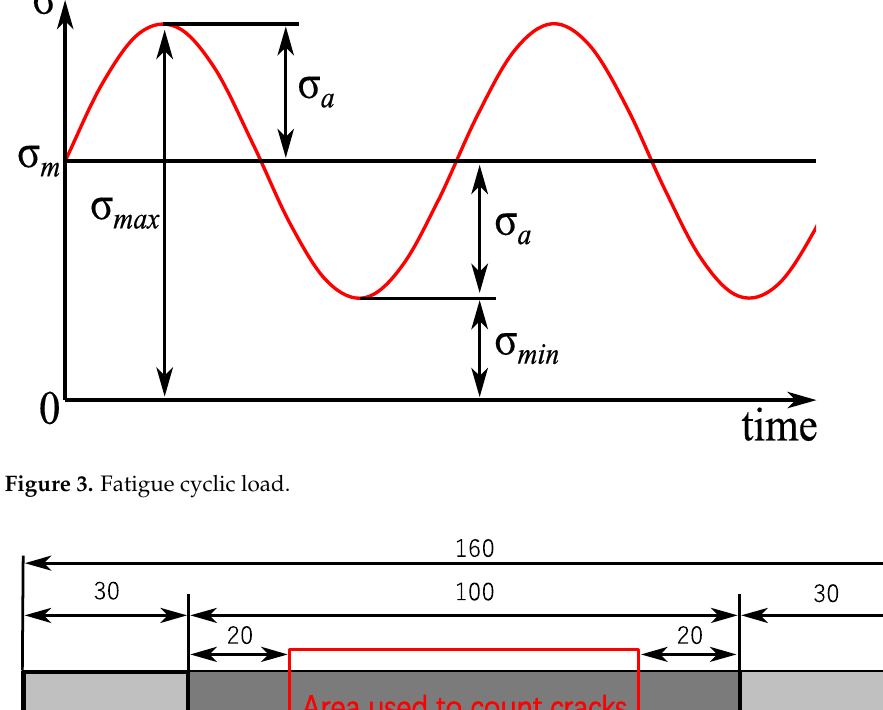
Figure 2. Fatigue loading machine (Shimadzu, EHF-LV020K1A).